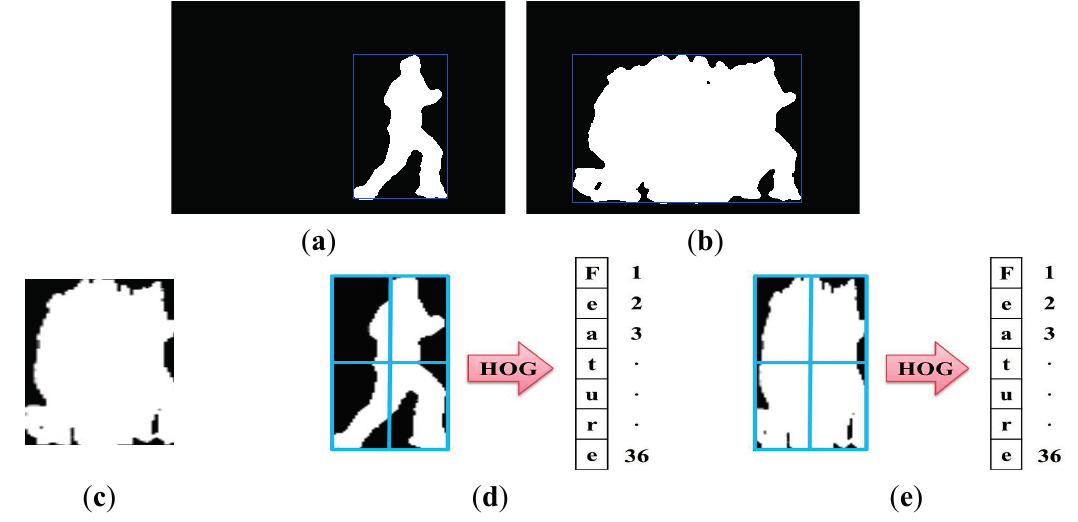
Figure 15. Segmentation images and feature extraction processes: ( a ) motion image; ( b ) MHI image; ( c ) DM; ( d ) DH; ( e )